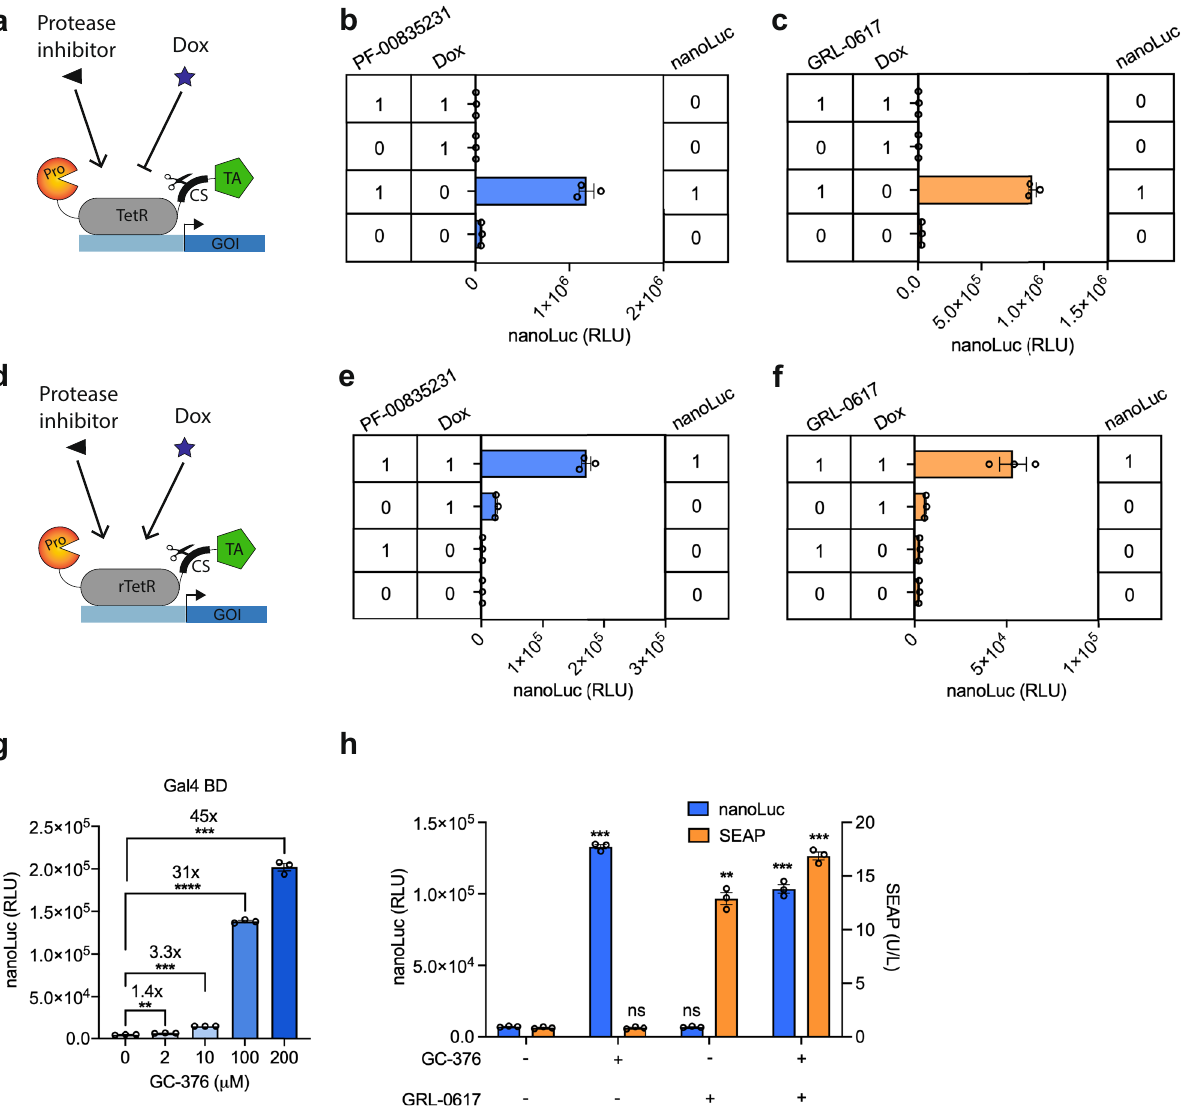
Fig. 5 Logic operations and multiplexing using TAGS. a Design of dual-input TAGS able to perform NIMPLY logic function. Transgene expression occurs only in the presence of a protease inhibitor and absence of doxycycline, which can be turned off by adding doxycycline to prevent TetR binding to DNA operator sequence upstream of the transgene. b , c Performance of NIMPLY logic gates based on b Mpro-TAGS using the Mpro inhibitor PF-00835231 and c PLpro-TAGS using PLpro inhibitor GRL-0617. d Design of dual-input TAGS able to perform AND logic function. Transgene expression occurs only in the presence of both protease inhibitor and doxycycline which preserve synTF and enable the rTetR to bind to the promoter region. e , f Performance of AND logic gates based on e Mpro-TAGS using the Mpro inhibitor PF-00835231 and f PLpro-TAGS using PLpro inhibitor GRL-0617. g Performance of Mpro- TAGS based on Gal4 BD. HEK293T cells co-transfected with pAna225 (P 5xUAS_ ssnanoLuc-sTRSV-pA) and pNF186 (P PGK _Mpro-Gal4 BD-CS OPT -VP64-pA) were treated with different concentrations of the Mpro inhibitor GC-376 for 24 h before measuring the luminescence of nanoLuc. h Multiplexing Mpro- and PLpro-based TAGS. Mpro-TAGS controlling nanoLuc expression and PLpro-TAGS controlling SEAP expression were co-transfected into HEK293T cells, which were then treated with combinations of GC-376 and GRL-0617 at 50 μ M for 24 h before pro fi ling reporter expression level. Data are shown as mean ± SEM, with individual data points, n = 3 biological replicates. Statistical signi fi cance was calculated by means of Welch ’ s two-tailed t -test, ** P < 0.01, *** P < 0.001, **** P < 0.0001, ns, not signi fi cant; exact P values are provided in Supplementary Table 7. Numbers above the bars indicate a fold difference in reporter expression level, calculated by dividing the mean expression level in the presence of inducer by the mean reporter expression level in the absence of inducer. Source data for this fi gure is provided in a Source Data fi